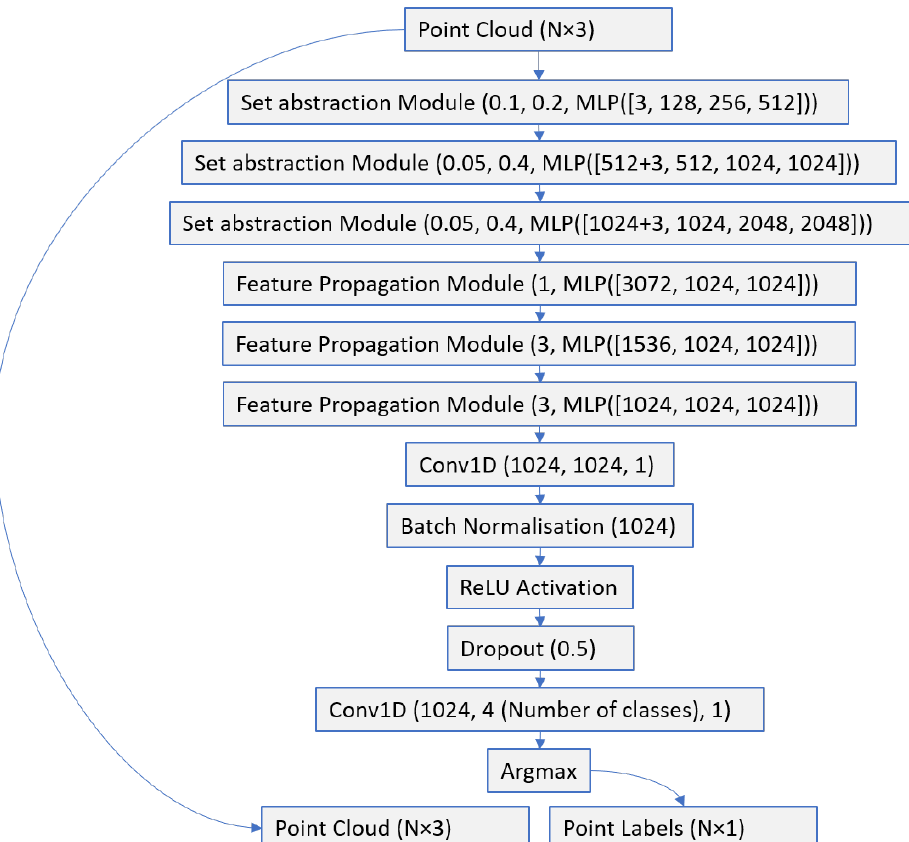
Figure 5. The network architecture used in this paper was based upon the Pytorch Geometric [40] implementation of Pointnet++ [35] with some modifications to increase the size and learning capacity of the network. Abbreviations: Multilayer Perceptron (MLP), 1 Dimensional Convolution (Conv1D), Rectified Linear Unit (ReLU).